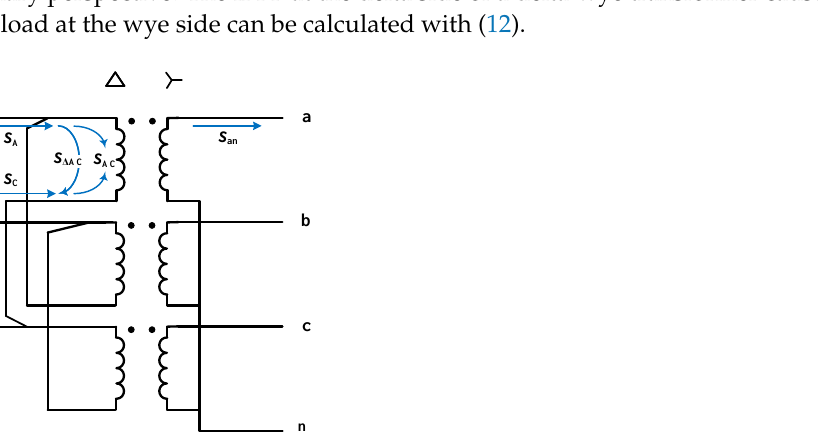
Figure 4. A circuit diagram of a delta-wye transformer (Dy1) and the IPPF at the delta winding as a result of a phase a load on the wye